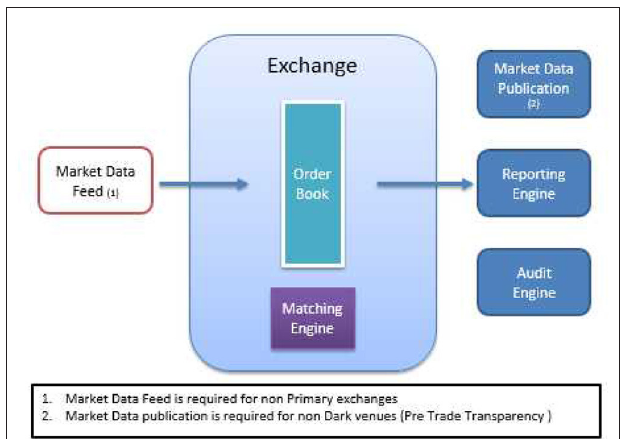
FIGURE 2 | Trading platform basic components.